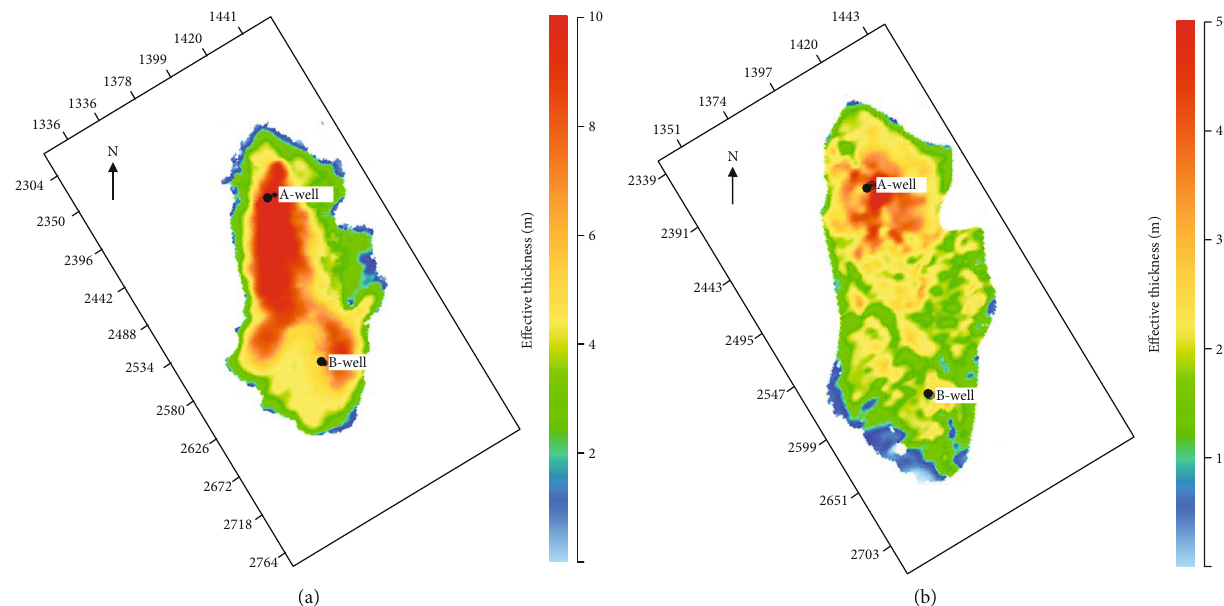
Figure 18: Plane distribution of average e ff ective thickness for gas hydrate and free gas in the A-B ore